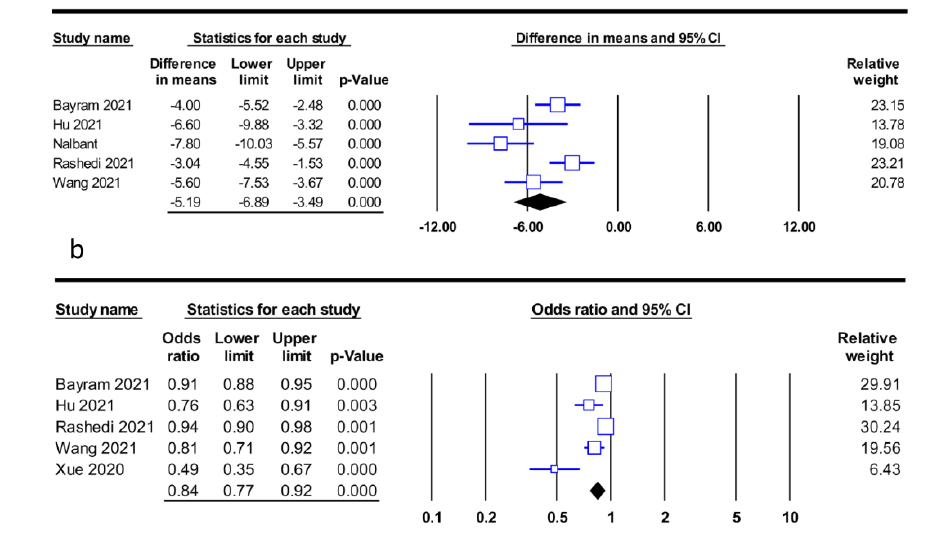
Figure 4. ( a ) Forest plot comparing the prognostic nutritional index (PNI) between severity and non-severity groups, showing a lower PNI in the severity group compared to the non-severity group (MD: − 5.19, 95% CI: − 6.89 to − 3.49, p < 0.001, I 2 = 73.4%) [19,21,33,35,36], and ( b ) Forest plot demonstrating a negative association between disease severity and PNI as a continuous variable (odds ratio: 0.84, 95% CI: 0.77 to 0.92, p < 0.001, I 2 = 83%) [19,30,31,35,36]. CI, confidence interval.